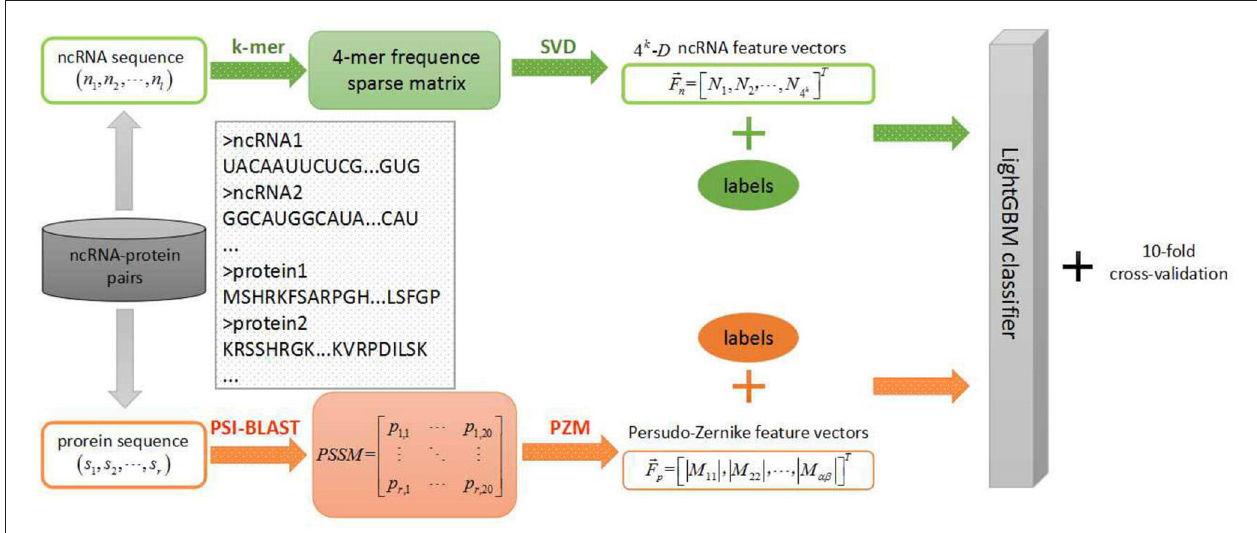
FIGURE 1 | Step-wise work flow for the purposed LGBM machine learning model.